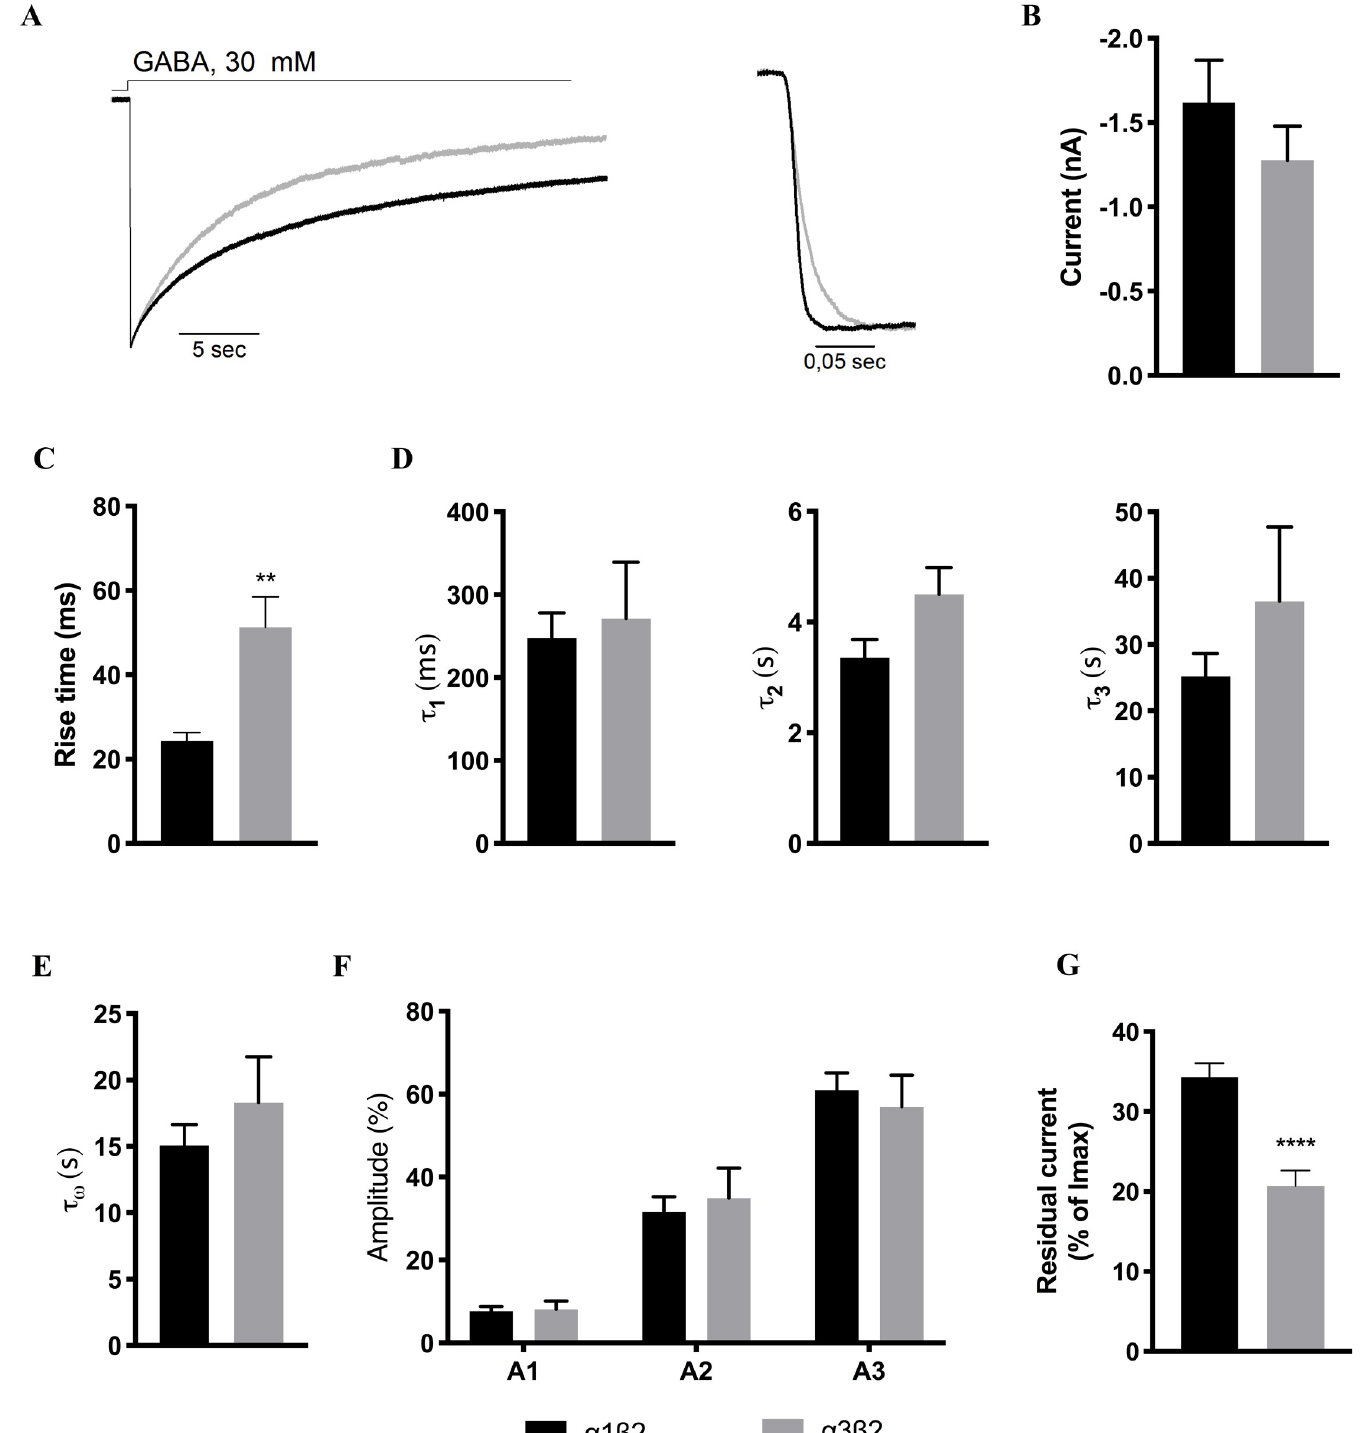
Fig 1. Kinetic properties exhibited by WT α 1 β 2 and α 3 β 2 receptors. A. Representative current traces for wild-type α 1 β 2 (black) and α 3 β 2 (grey) receptors ( left ) and the activation phases of α 1 β 2 (black) and α 3 β 2 (grey) from representative current traces ( right ) B. Averaged peak currents for α 1 β 2 (black) and α 3 β 2 (grey). The n- values are given in Table 1. C-G. Averaged values (mean ± S.E.M.) for various kinetic parameters for α 1 β 2 (black) and α 3 β 2 (grey) are given. Statistical differences are indicated with asterisks (Welch’s ANOVA, � P < 0.05). The averaged data and n-values are given in Table 1. C . Activation . Averaged rise times (10–90%) of the activation phase exhibited by α 1 β 2 and α 3 β 2 receptors. D-F . Decay . τ 1 , τ 2 , and τ 3 are given in D, τ W values are given in E and the current fractions A 1 , A 2 and A 3 in F. G . Residual currents . The averaged residual currents for the two WT receptors are given.